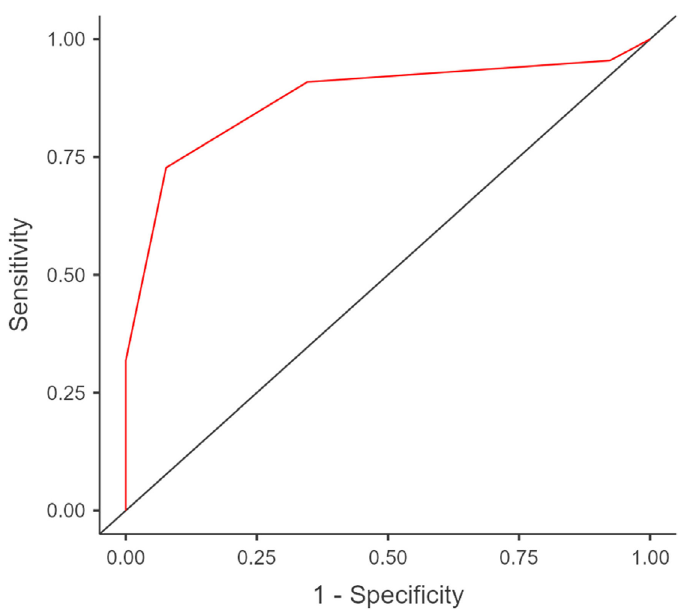
Figure 3- Specificity sensitivity